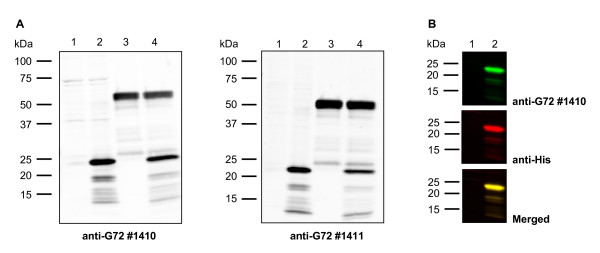
Validation of anti-G72 antibodies using western blotting and LI-COR Odyssey® Infrared Imaging System. (A) Western blotting was performed using rabbit polyclonal antibodies anti-G72 #1410 (left) or anti-G72 #1411 (right). Lane 1: total protein lysate from mock-transfected HEK-293 cells. Lane 2: total protein lysate from His-G72-transfected HEK-293 cells. Lane 3: Eluate from immunoprecipitation (IP) of mock lysate with anti-G72 #1411. Lane 4: Eluate from IP of His-G72 lysate with anti-G72 #1411. A strong signal for His-G72 was detected at ~22 kDa (lanes 2 and 4), with weaker bands around 18 kDa and below. Additional bands in lanes 3 and 4 (weak signal at 25 kDa and strong signal at 50 kDa) represent the light and heavy chain of the antibody used for IP. (B) G72-specific antibody #1410 (upper panel, green) and a commercial anti-His antibody (middle panel, red) detect the same protein bands on Western blots (merged image, lower panel, yellow) in total protein lysates from HEK-293 cells overexpressing His-G72. Lane 1 & lane 2: as described in A.